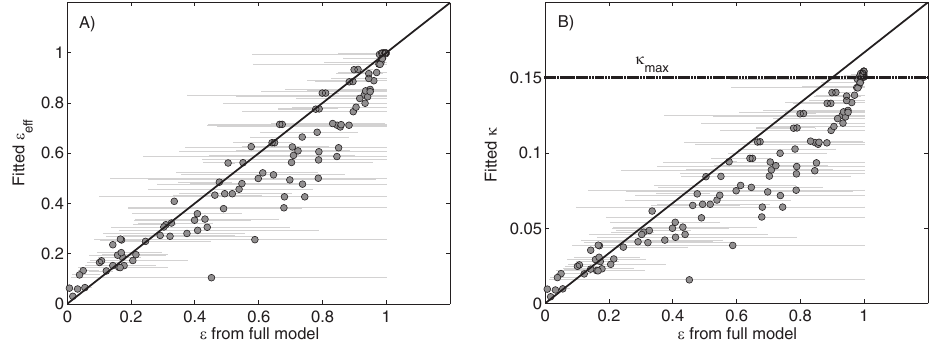
Figure 7. (a) The fitted soluble fraction ε eff as function of the true dissolved fraction ε for each considered mixture (see Table 2). Symbols: mean ε over all activation points. Grey lines: the range of ε values at the different activation points for a given mixture. (b) The fitted κ values as a function of the true dissolved fraction ε for each considered mixture. The red dashed line denotes the limit of κ max = 0 . 15 that applies to all the studied mixtures. 1:1 lines are also indicated.